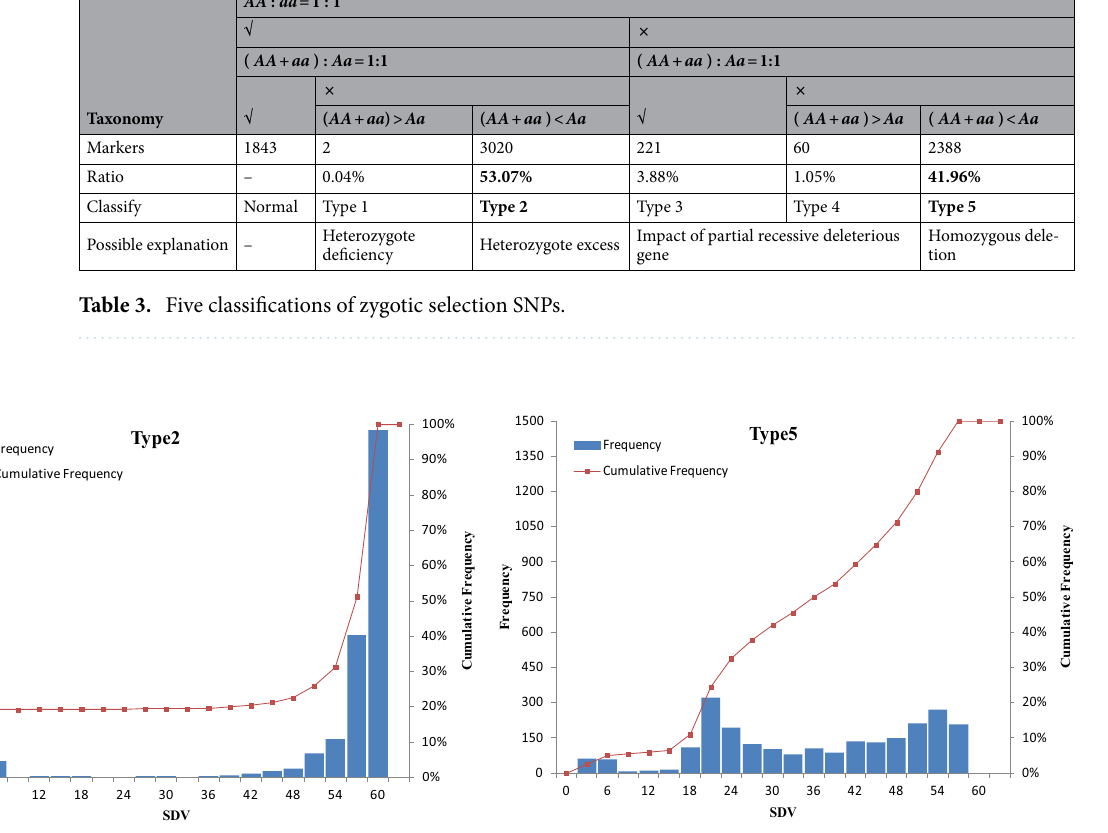
Figure 2. The SDV distribution pattern of deviated markers in type 2 (left) and type 5 (right). Type 2 refers to deviated markers classified as heterozygote excess and type 5 homozygous deletion according to our taxonomy respectively. In both panels, abscissa shows extent of SDVs of these markers. Left ordinate indicates the frequency of markers fallen into each section and is shown in histogram. Right ordinate indicates the cumulative frequency of these markers and is shown as polyline. SDVs of type 2 markers exhibit bimodal distribution. Over 80% of deviated type 2 markers show higher SDV in comparison to the relatively lower SDV of type 5 markers.